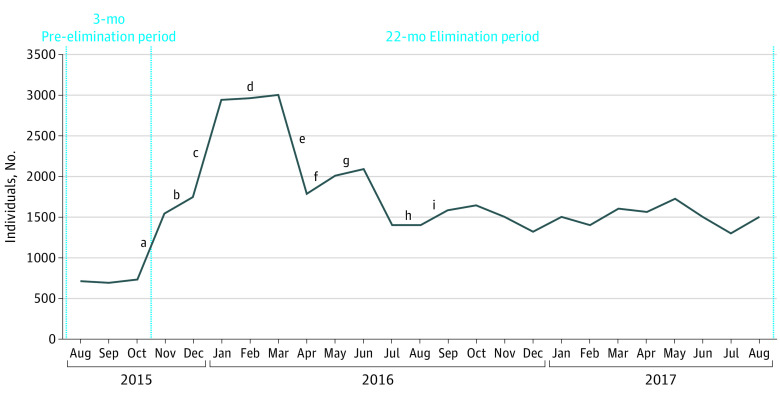
Individuals Aged 20 to 69 Years Screened for Hepatitis C Virus (HCV) Antibodies During the 3 Months Preceding the Elimination Program and During the Elimination PeriodaThe universal screening policy was implemented at the Cherokee Nation Health Services (CNHS) on November 1, 2015.bLaboratory-triggered screening (LTS) was initiated at WW Hastings (WWH) Hospital in December 2015.cUse of in-house tests for HCV antibody screening was initiated at satellite clinics on January 1, 2016.dPoint-of-care testing was initiated at WWH Hospital dental clinic in March 2016.eDiscontinuation of LTS occurred on March 31, 2016.fResumption of LTS with consent to treat on file occurred on May 19, 2016.gPoint-of-care testing was initiated at 1 satellite dental clinic in June 2016.hUse of electronic health record reminders in the new CNHS electronic health record system was initiated on July 19, 2016 (LTS with consent to treat on file was discontinued).iPhysician training on use of the new EHR reminder occurred in July and August 2016. Point-of-care testing was implemented at WWH Hospital Behavioral Health Clinic in August 2016 but was not implemented systematically.